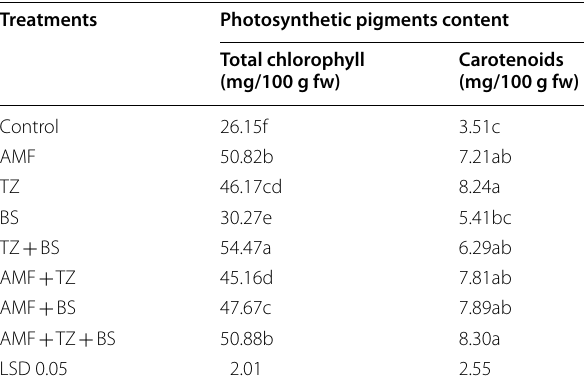
Table 2 Effect of AMF and PGPRs individually or in combinations on total chlorophyll and carotenoids in squash leaves